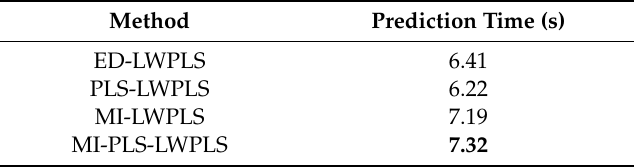
Table 5. Comparison of the response time of the four methods.